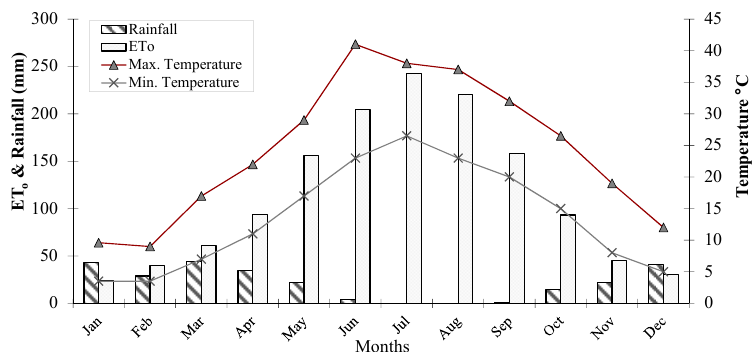
Figure 1. Average monthly rainfall, reference evapotranspiration (ET o ) and maximum and minimum temperature at Ras ‐ El ‐ Ain (1993–2002).